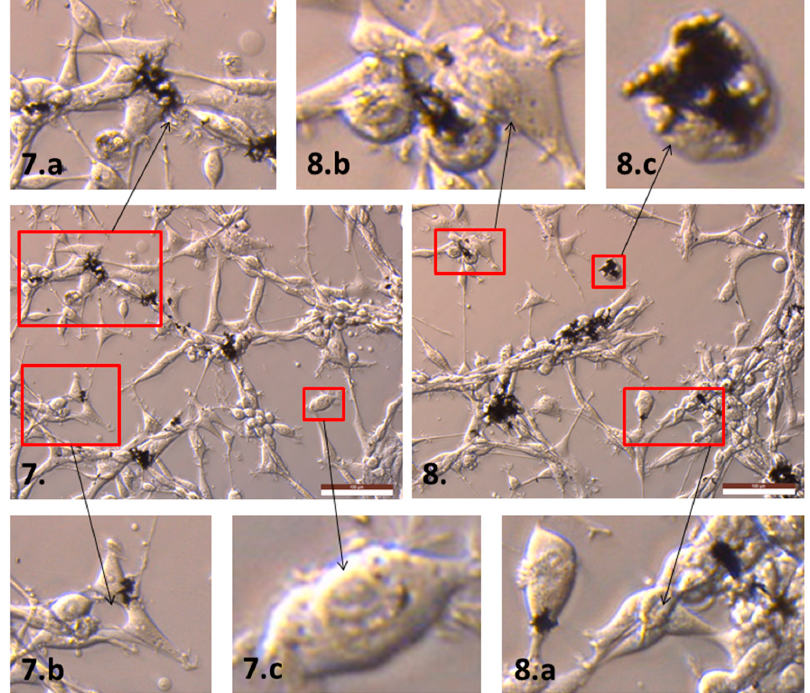
Figure A4. Morphology of U87 cells treated with rGO flakes, as evaluated by optical microscopy. Cells treated with graphene flakes (at concentration of 50 µ g/mL)—(7–8) rGO/TUD. Regions of interest marked with red borders, are shown enlarged, and are indicated by black arrows. Scale bar: 100 µ m.